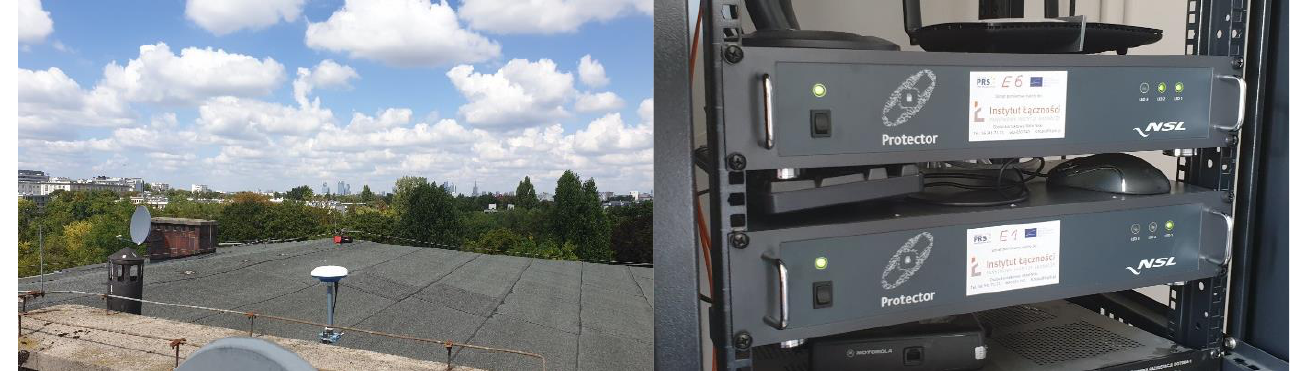
Figure 3. The Polish STRIKE-P monitoring